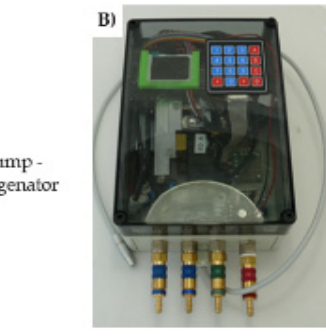
head of 60 mmHg. The gas blender unit also contains the overall control system.